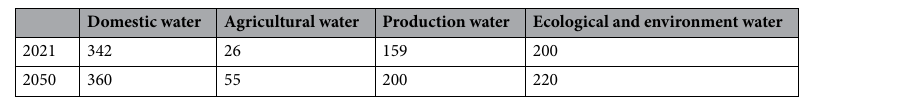
Table 1. Economic benefit coefficient of each water consumption department (CNY/m 3